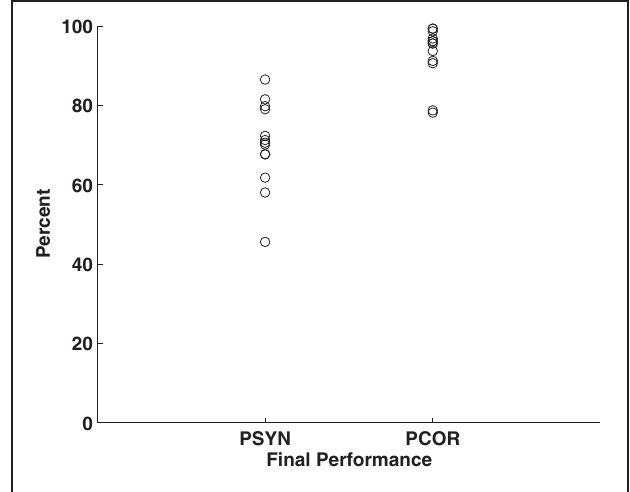
FIGURE 1 | Plot of individuals’ final performance on PCOR and PSYN. Points represent individual mean scores for the final run of Day